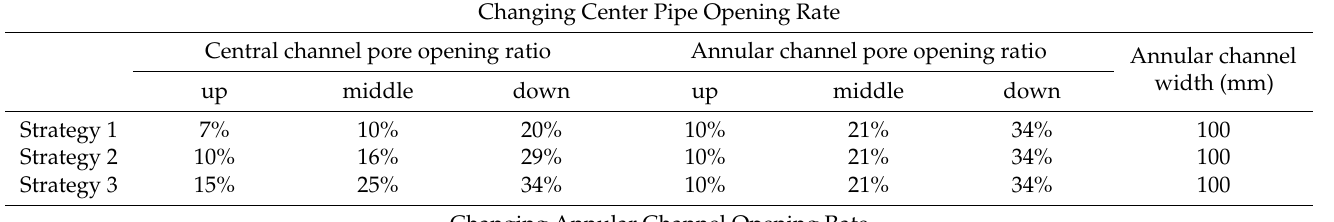
Table 3. Variable parameters of the